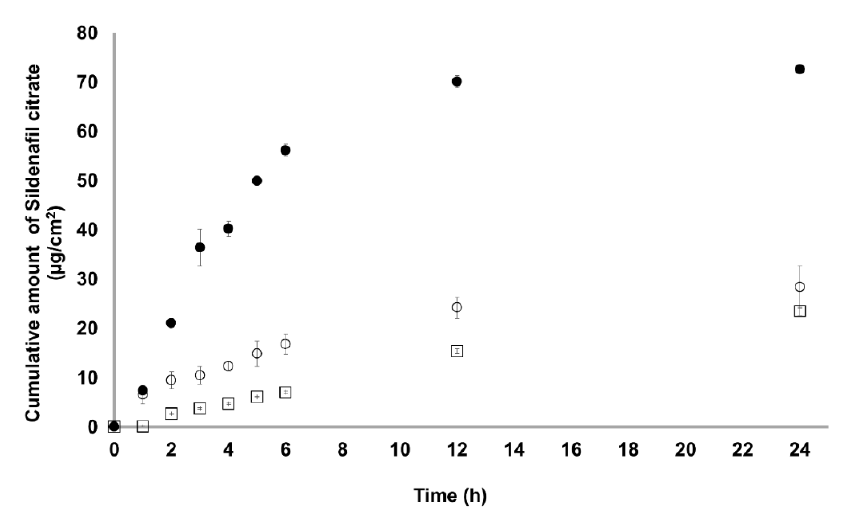
Figure 6. Transdermal permeation of the sildenafil citrate microemulsion-loaded hydrogel ( • isopropyl myristate-based system; oleic acid-based system) and sildenafil citrate suspension ( ) across the Strat-M ® membrane in a citrate bu ff er solution at pH 5.8 ( n = 6). Table 7. Skin permeation parameters of the sildenafil citrate formulations through a Strat-M membrane in vitro after 24 h. Sildenafil Sildenafil Sildenafil Citrate Parameter Microemulsion Microemulsion Suspension (IPM System) (OA System) Cumulative amount at 24 h ( µ g / cm 2 )